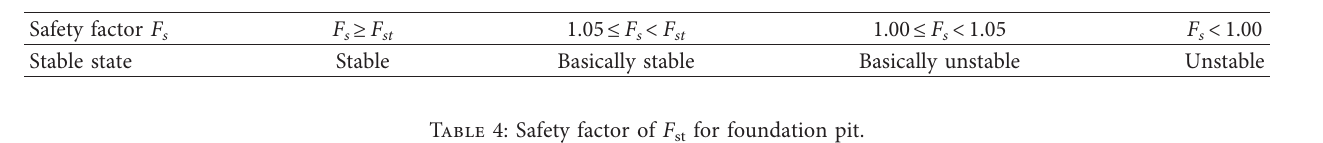
st for foundation